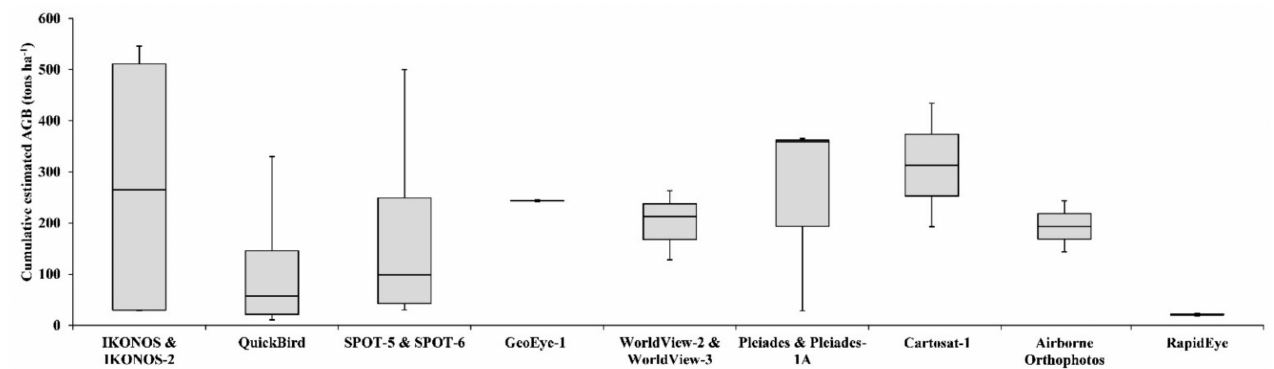
Figure 5. Boxplot for estimated mean AGB and RMSE (t ha − 1 ) for each sensor reviewed in all reported